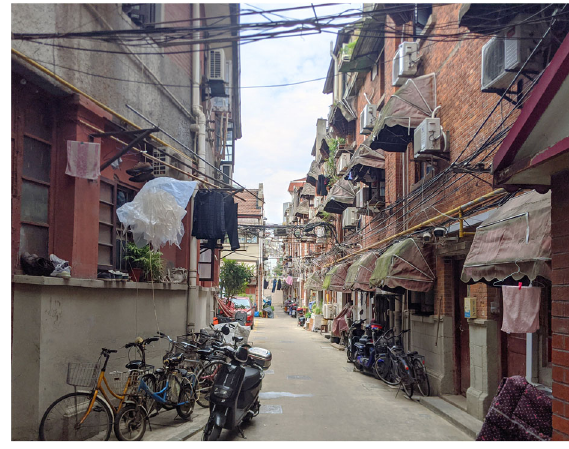
Fig. 5 The organized terraced buildings in Bugaoli, constructed with red bricks and timber window frames and door panels on the architectural façades (Source: Kaiyi Zhu,